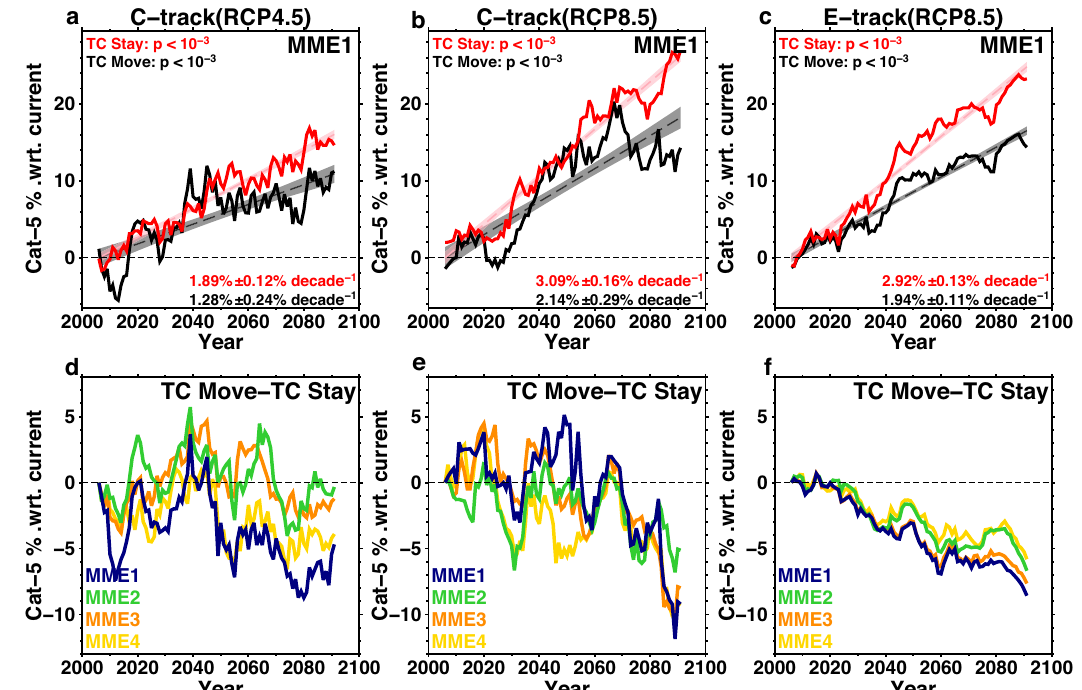
Fig. 3 Time series of the portion of Category-5 PI (i.e. Category-5 PI count over total PI count). Top ( a , b , c ): Proportion of Category-5 PI time series of the 3 track groups, with trends and p-values, based on MME1. 95% con fi dence trend bounds are shaded. The regression lines are aligned at the zero point for trend comparison. Bottom ( d , e , f ): The difference between TC_Move and TC_Stay, i.e., poleward migration ’ s negative effect, for the 3 track groups. All 4 MMEs are